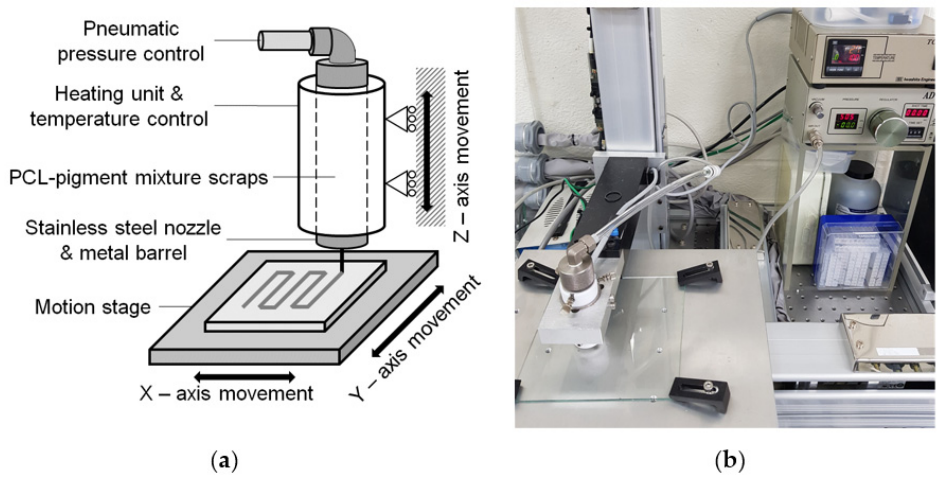
Figure 2. Experimental setups for extrusion-based 3D printing: ( a ) schematic diagram and ( b ) actual apparatus.